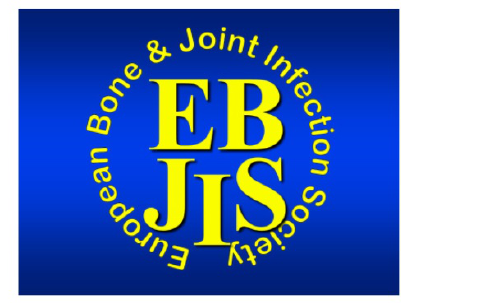
Figure 2. Logo of EBJIS, as Created by the Author in 1993